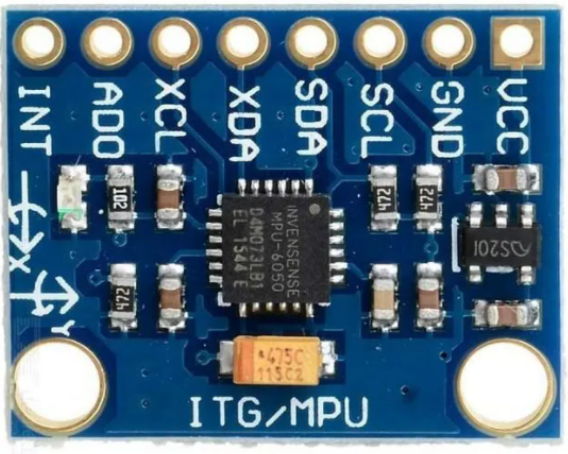
Figure 31. The MEMS accelerometer MPU6050 was used to measure the PIG’s acceleration.